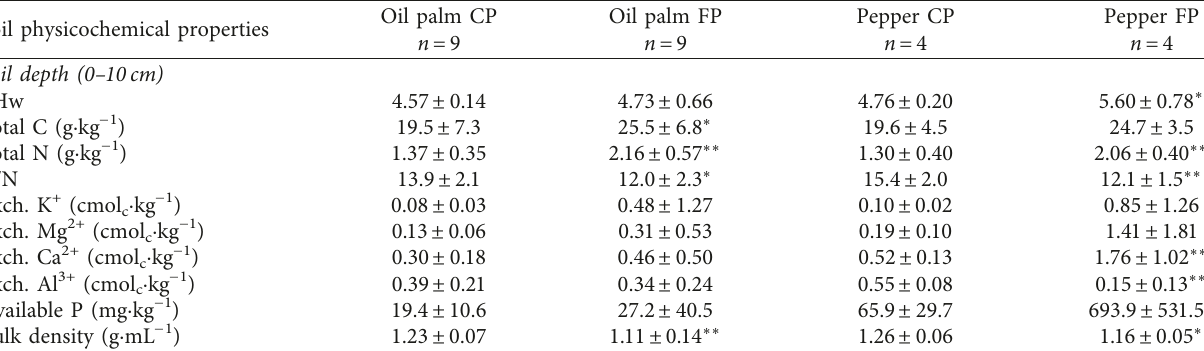
Table 5: Comparison of selected soil physicochemical properties at 0–10cm depth of centre point (CP) and fertilizing point (FP) in oil palm and pepper land